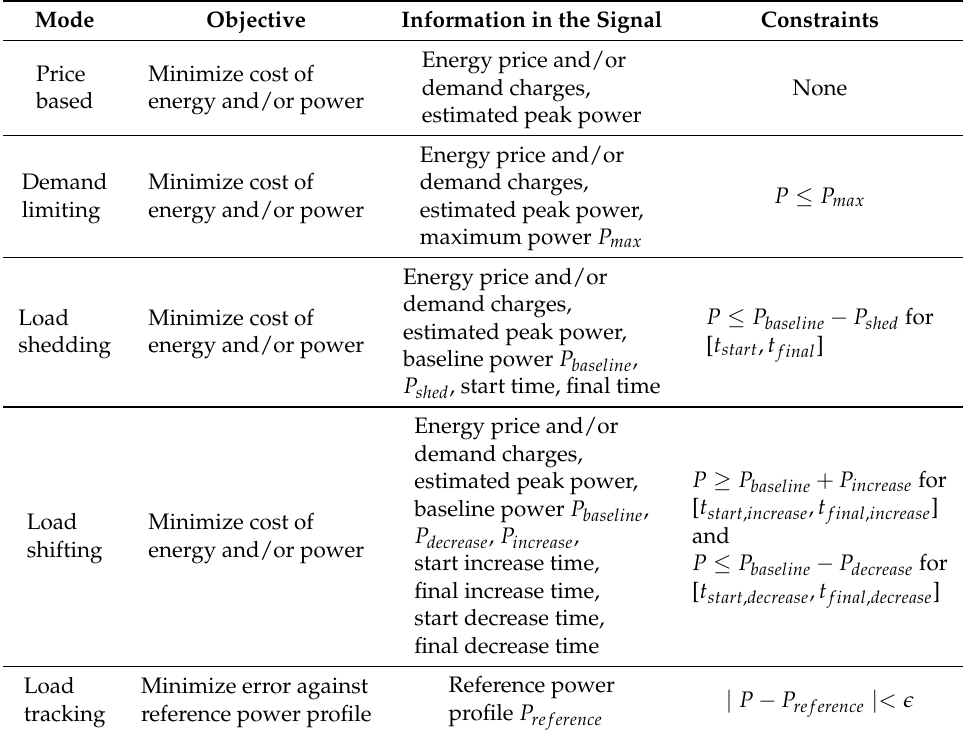
Table 1. MPC configuration for handling different grid